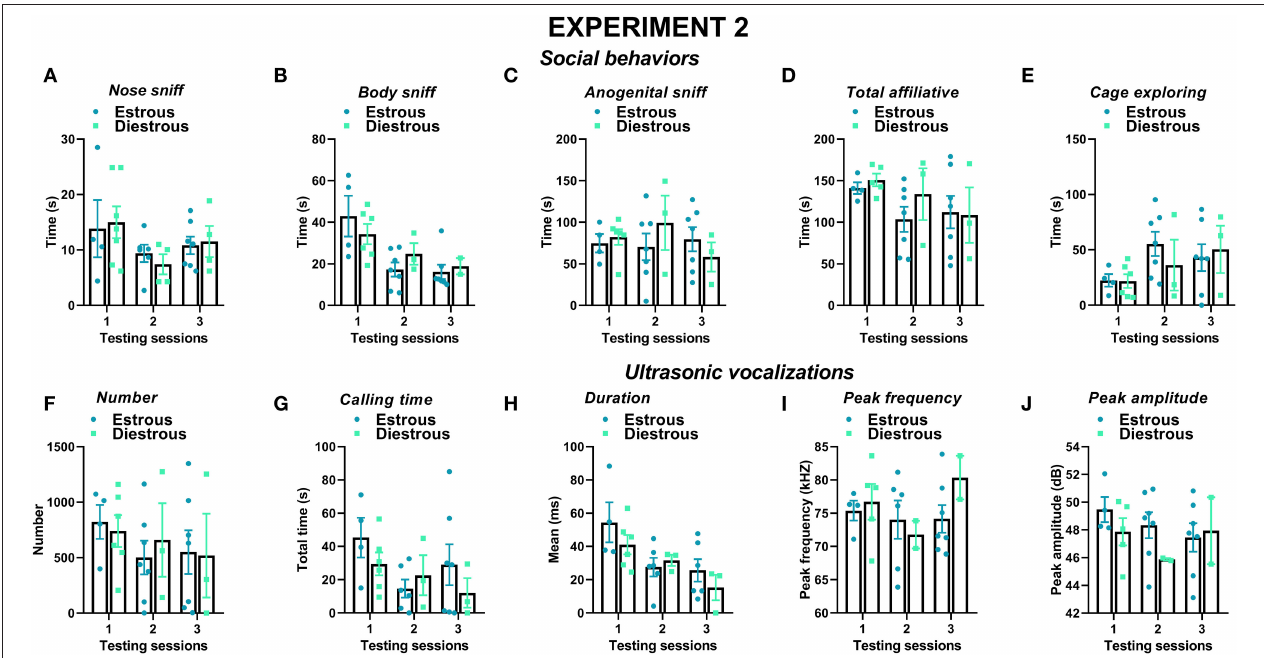
FIGURE 9 | Effects of the estrous phase of the resident female mice on social behaviors and USVs in experiment 2 (different pre-testing isolation). The effects of the estrous phase of the experimental female B6 subjects were investigated on each testing day on (A–E) social behaviors and (F–J) multiple USV characteristics. The B6 female mice were isolated for 3 days in the testing cage before each social encounter, as in experiment 1, while the male mice were isolated for only 10min pre-testing, as in most standard protocols. Social behaviors and USVs were analyzed following otherwise the same procedures used for experiment 1 (3 testing sessions of 3min each and at an interval of 7–10 days). A detailed distribution of the estrous phase in the female residents and intruders is provided in Table 1 . Data are mean ± SEM. N = 10 before exclusion of statistical outliers by Grubb’s test for small